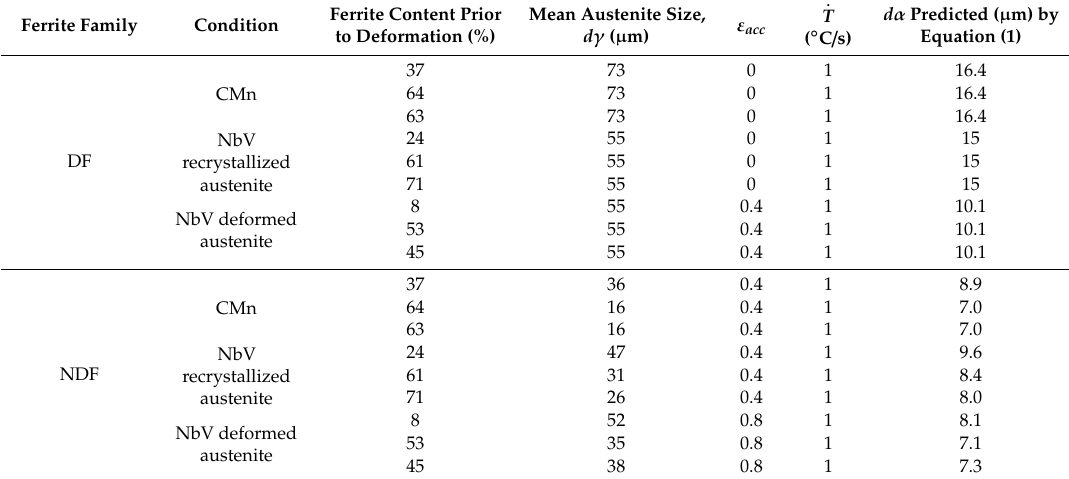
Table 3. Predicted mean ferrite grain sizes for both ferrite families considering Equation (1) [19] and the variables considered in each condition.